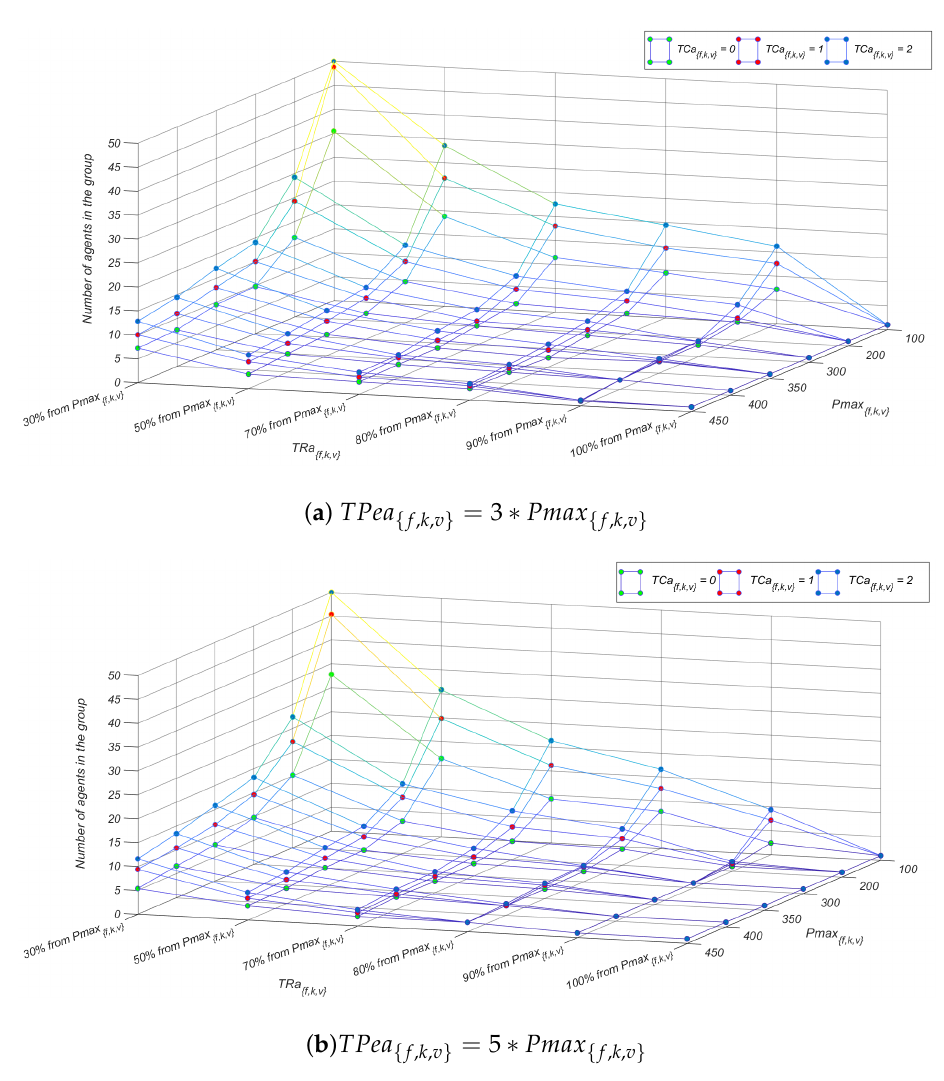
Figure 3. The number of agents added in the group at the 10,000th iteration of the exploration process: Pa { f , k , v } = Pmax { f , k , v } , the exploration space size represented 10 × 8 × 5 cells, TPea { f , k , v } = 3 ∗ Pmax { f , k , v } , and TPea { f , k , v } = 5 ∗ Pmax { f , k , v }